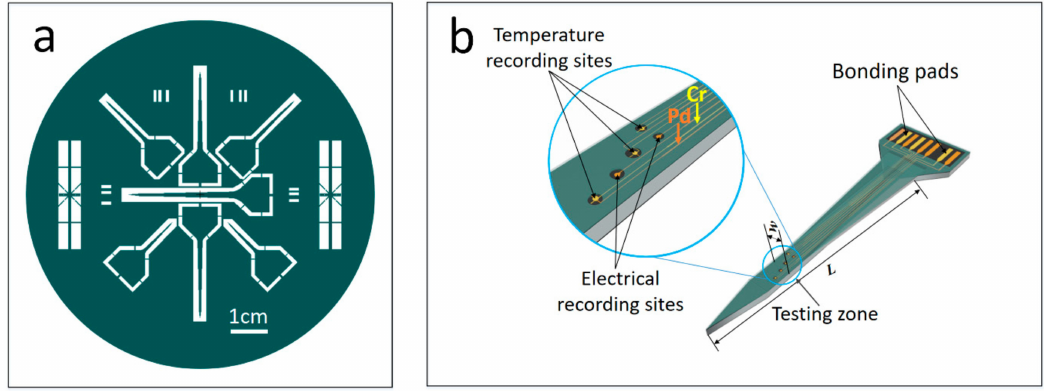
Figure 1. ( a ) Overall design of seven 3D micro-probes on a 4 in.-diameter s.s. substrate. ( b ) Schematic figure of the structure of a multifunctional 3D micro-probe.